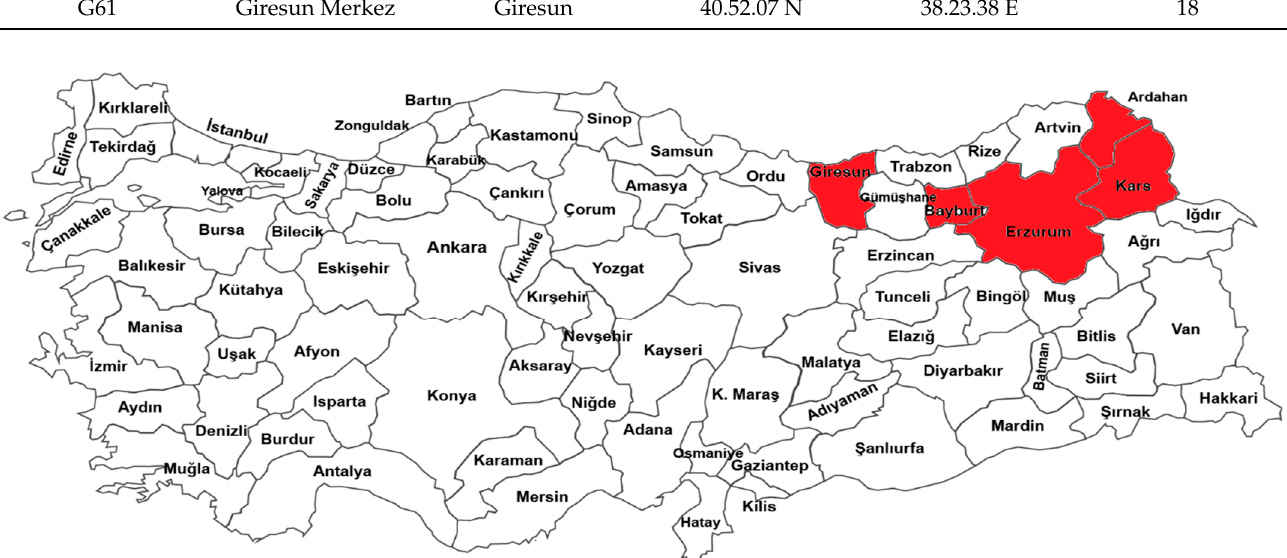
Figure 1. Geographic distribution of forage pea landraces collected from various geographical provinces in the northeastern Anatolia region of Turkey.